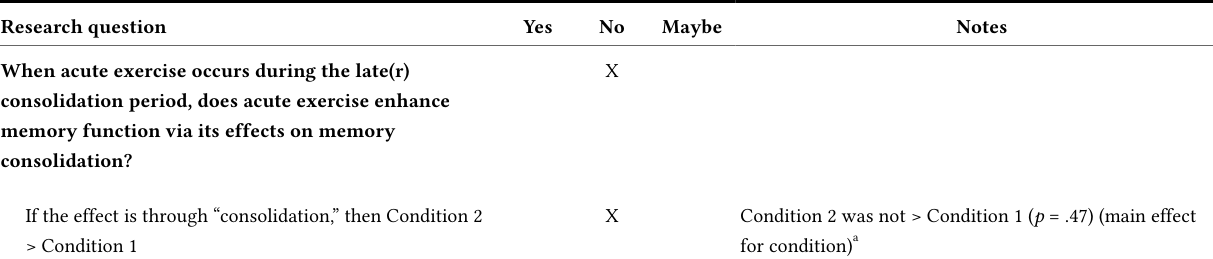
Summary of Results for Experiment